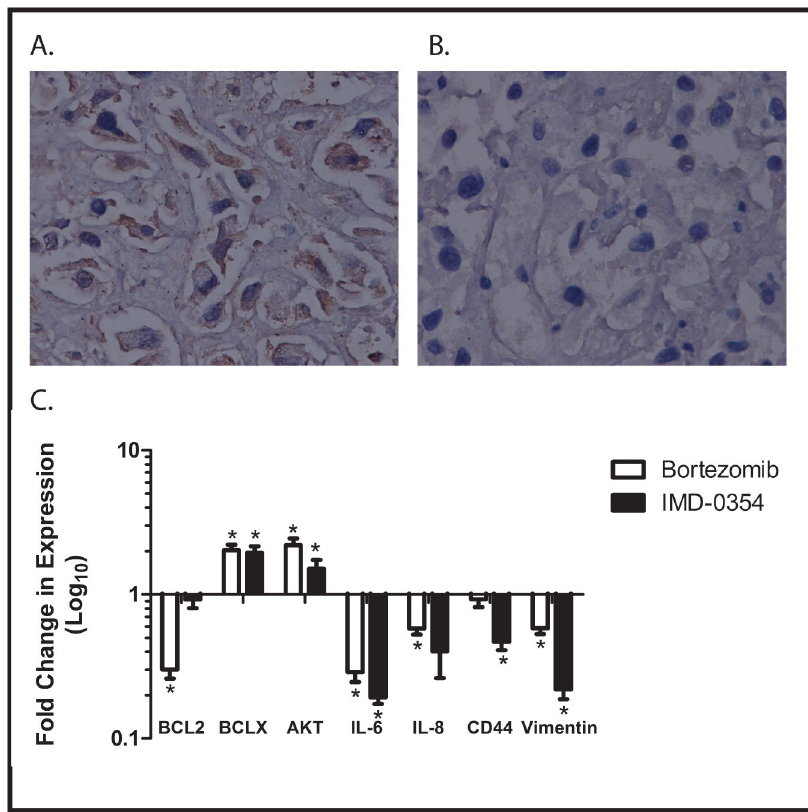
Figure 5. A) Immunohistochemical analysis of sections of xenograft from control mice showing expression of NF-κB p65 (brown staining). (B) Immunohistochemical analysis of sections of xenograft from mice treated with bortezomib, also stained with antibody for the p65 subunit of NF-κB. No staining is evident in these sections. Images are at 200x magnification. C) RNA was isolated from xenografts growing in untreated, control mice, and in mice treated with either bortezomib or IMD-0354. After reverse transcription, quantitative RT-PCR was performed to measure expression of the indicated NF-κB target genes. Data are presented as fold change between mice treated with the indicated agent and control. Experiments were performed in triplicate, and error bars show standard error of the mean. *=achieves statistical significance compared to control (p<0.05) by two-tailed unpaired Student t